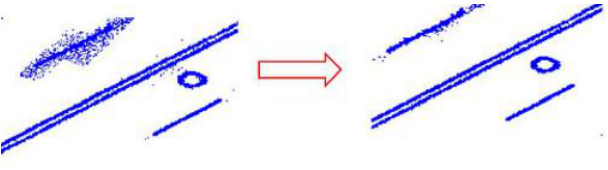
Figure 9. Dispersion degree filtering.